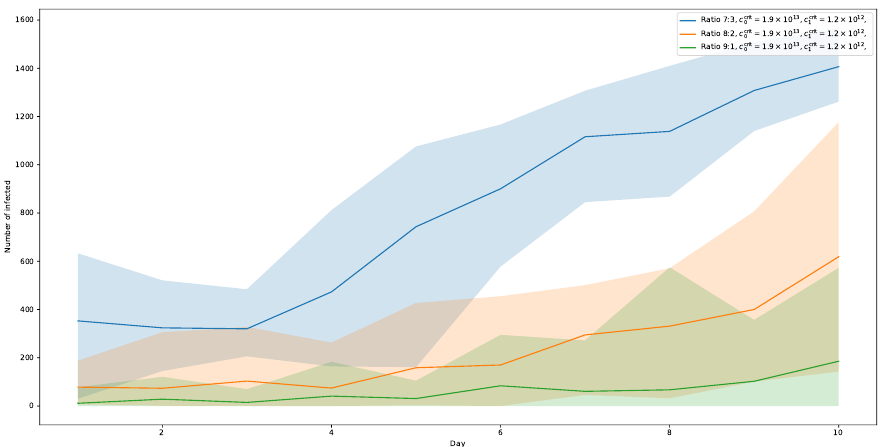
= 1.9 10 13 and c crit 1.2 10 12 . The number of infected is 0 1 × ×